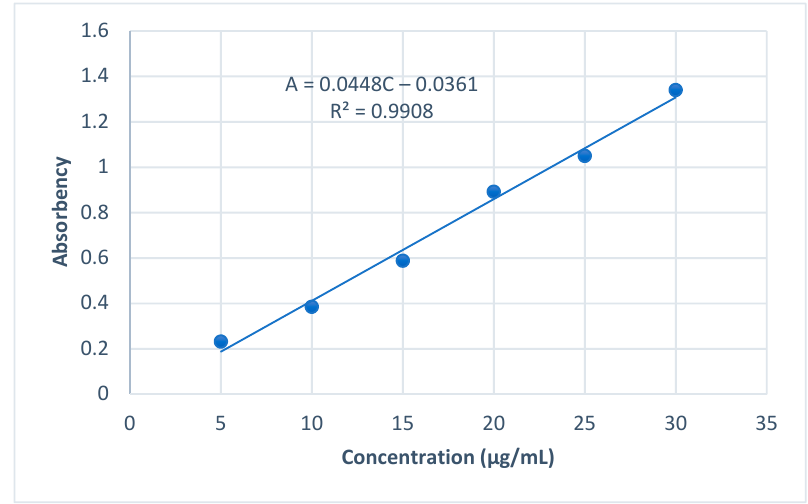
Figure 1. The standard curve of oleanolic acid.